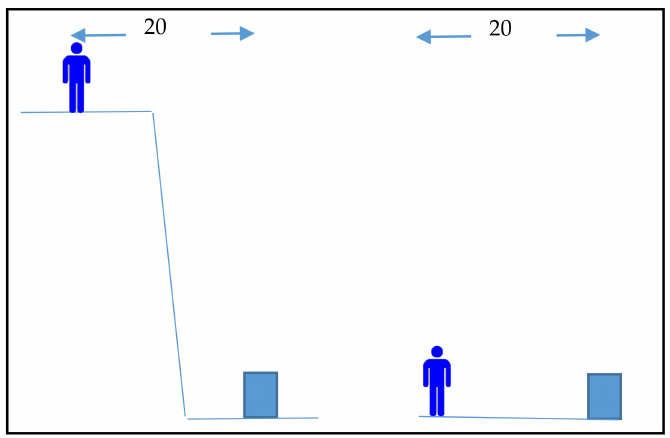
Figure 13. Effect of elevation to give wrong results for the proposed VGI quality assessment